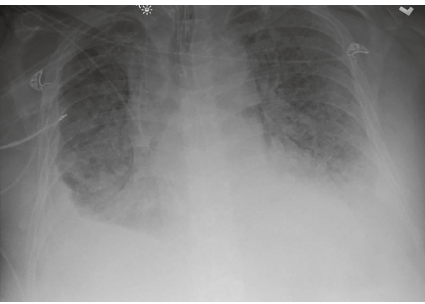
Figure 1: Chest radiograph showing bilateral diffuse infiltrates. Figure 2: CTscan of the chest showing multifocal airspace disease concerning pneumonia or oedema.